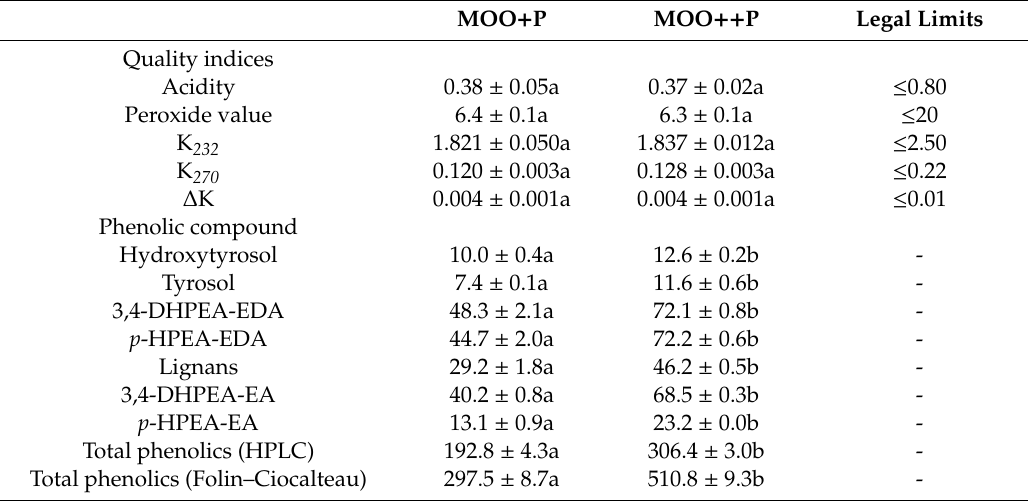
Table 1. Legal quality indices and phenolic compounds of MOO samples at two di ff erent level of EVOO phenolic